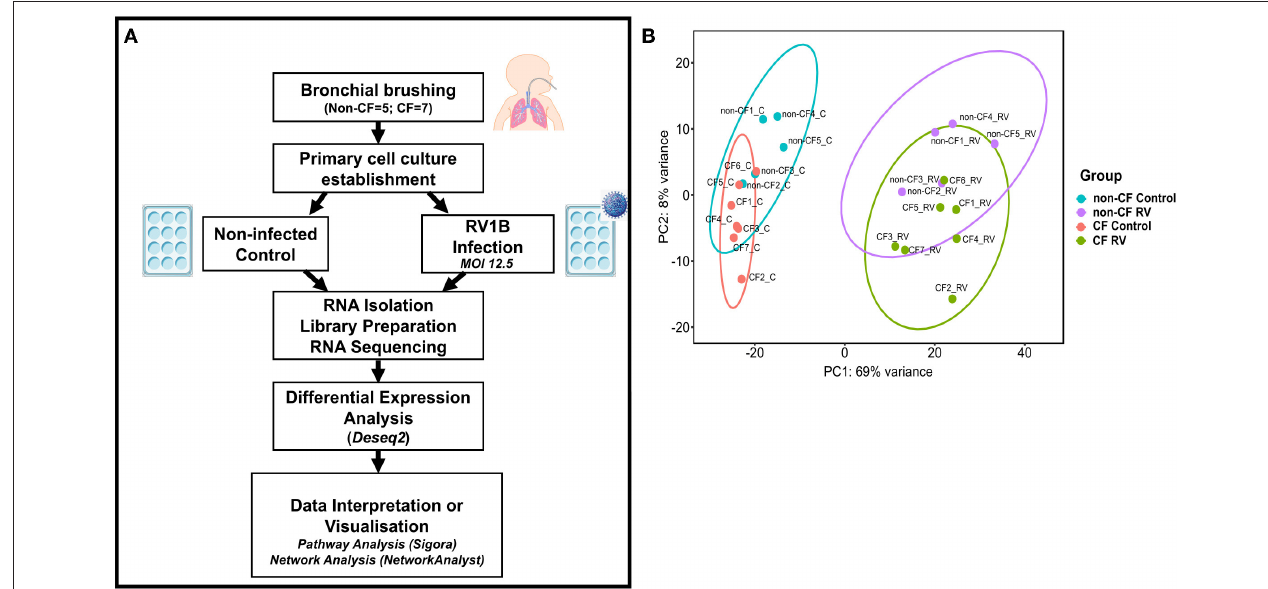
FIGURE 1 | Analytical methods. (A) Schematic workflow describing experimental procedure and transcriptomic analysis. Primary airway epithelial cells (AECs) from non-CF children ( n 5) and children with CF ( n 7) were obtained from bronchial brushings. AECs were established for infection with human rhinovirus 1B (RV1B) at = = MOI 12.5. At 24h post-infection, RNA was isolated and processed for library preparation. Sample libraries were sequenced on the Illumina HiSeq 2500 platform